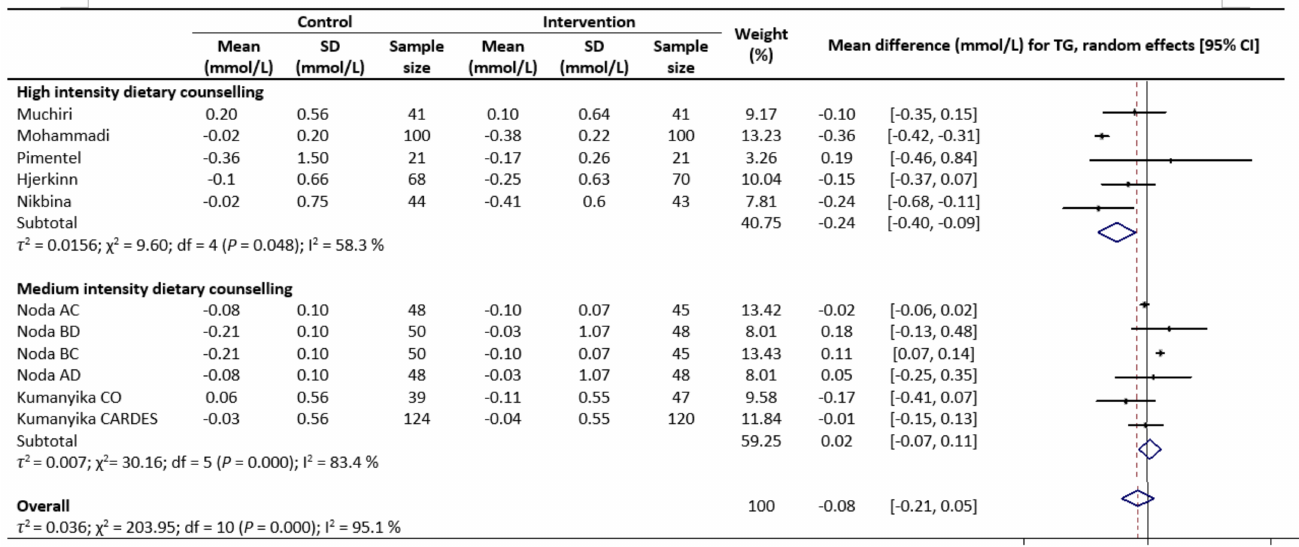
14.5 [11.40, 18.70] [ − 4.50, 1.93]